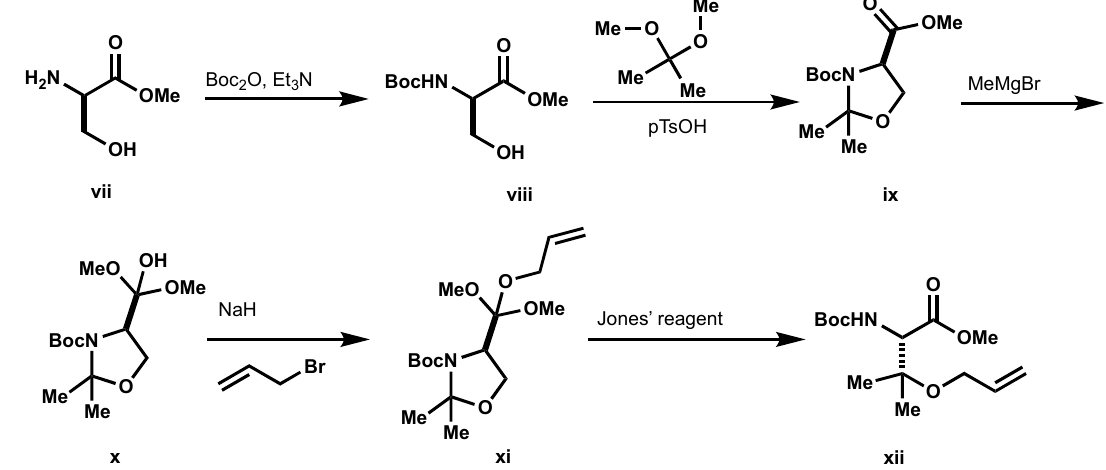
Scheme 4. Synthesis of starting material towards 17A and 17B (see Materials and Methods for experimental detail).